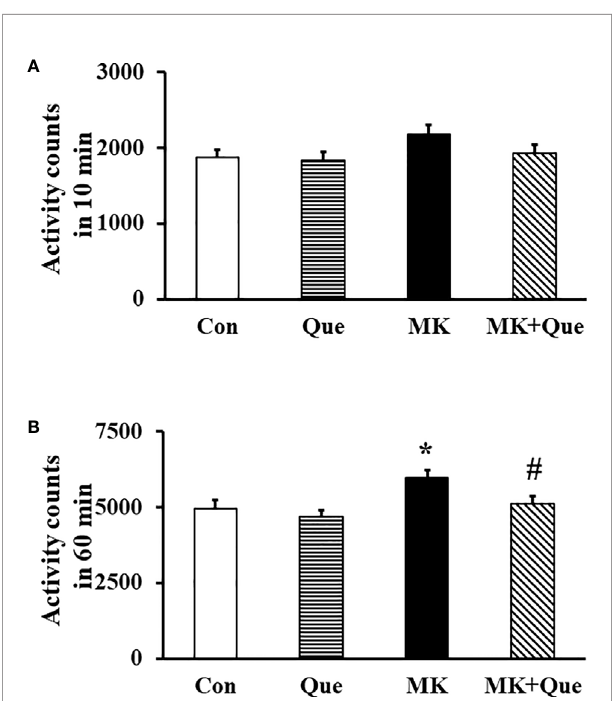
FIGURE 1 | Locomotor activity in the mice of control (Con), quetiapine (Que), MK-801 (MK), and MK-801+quetiapine (MK+Que) groups. Locomotor activity was measured at the fi rst 10 min (A) of 60 min and at the 60 min (B) . Quetiapine signi fi cantly attenuated the hyperlocomotor activity measured at 60 min in the MK-801 mice. n=10 in each group. Mice were treated with chronic quetiapine (10 mg/kg/day, intraperitoneally) for 28 days. From day 22 to 28, 1 h after the administration of quetiapine, the mice were administered MK-801 (2 mg/kg/day, subcutaneously). On day 29, locomotor activity was measured for 60 min in a plexiglas activity box. Results are expressed as means ± S.E.M. * P < 0.05 vs. Con, # P < 0.05 vs. MK.